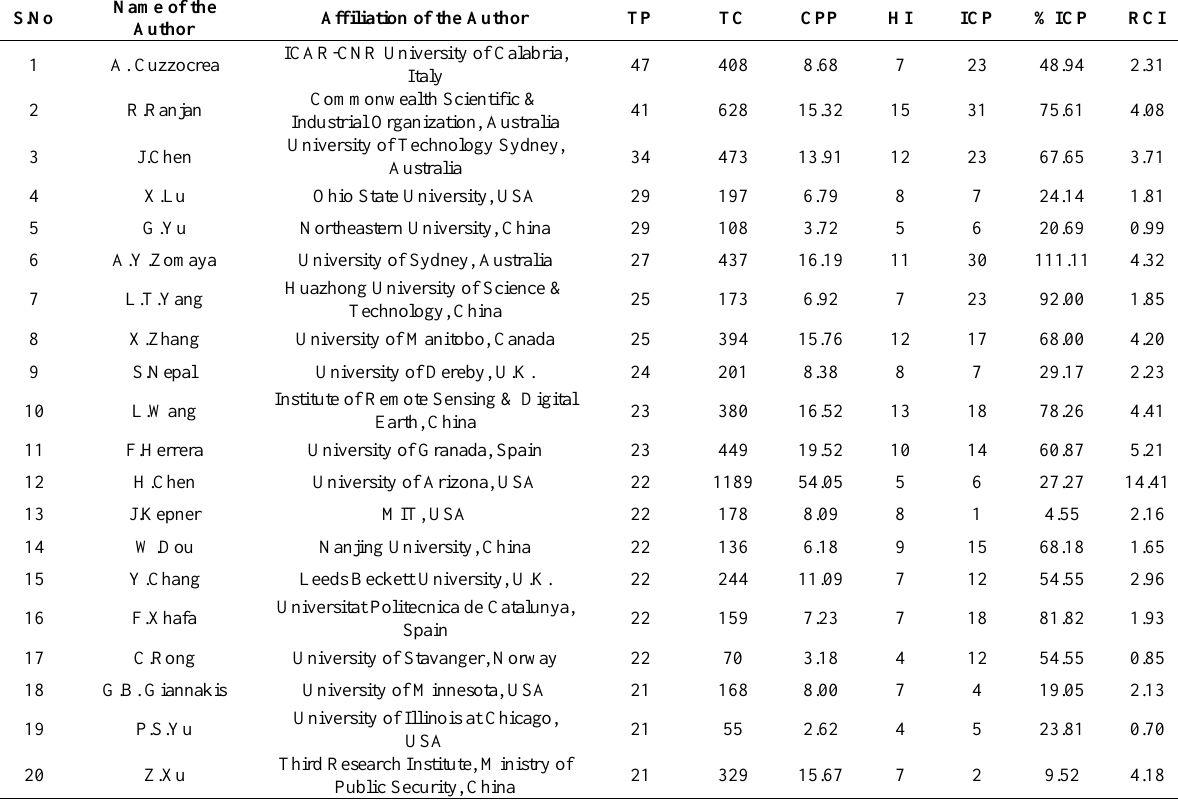
Table 9. Top 20 Most Productive Global Authors in Big Data Research,